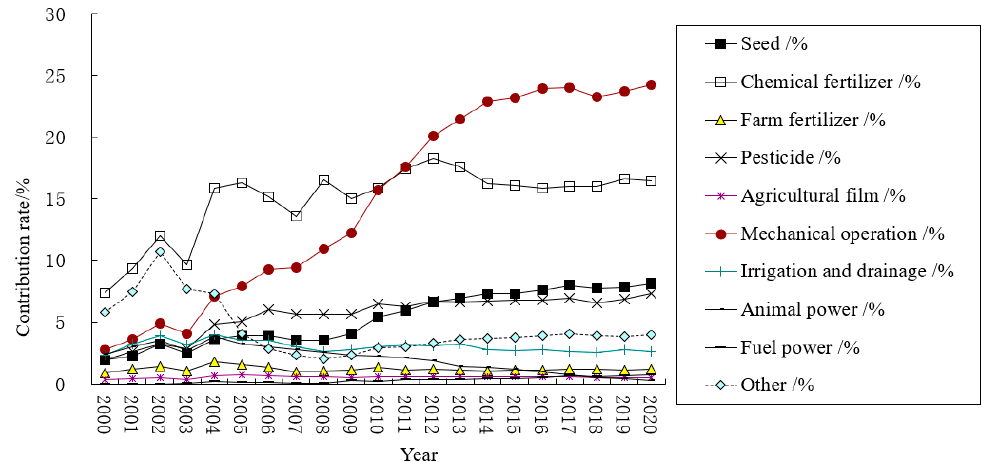
Figure 7. The trend of capital contribution rate and its decomposition from 2000 to 2020.